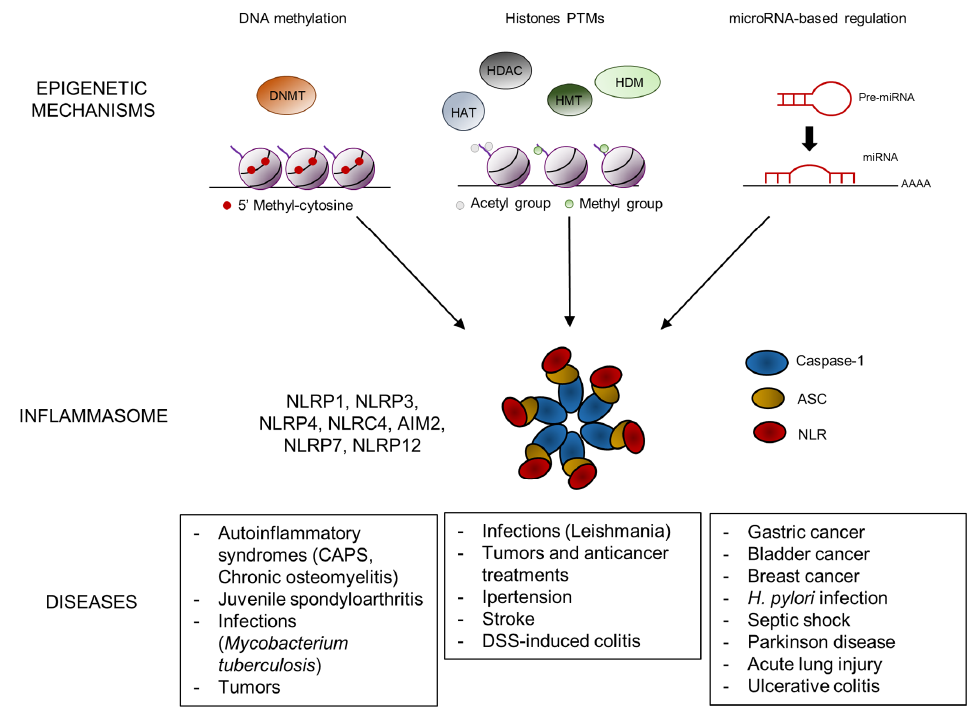
Figure 1. Schematic representation of the main epigenetic mechanisms involved in inflammasome activation. DNA methylation, histones post-translational modifications (PTMs) and microRNA-based regulation exert epigenetic control on the level of inflammasome activity, whose dysregulation